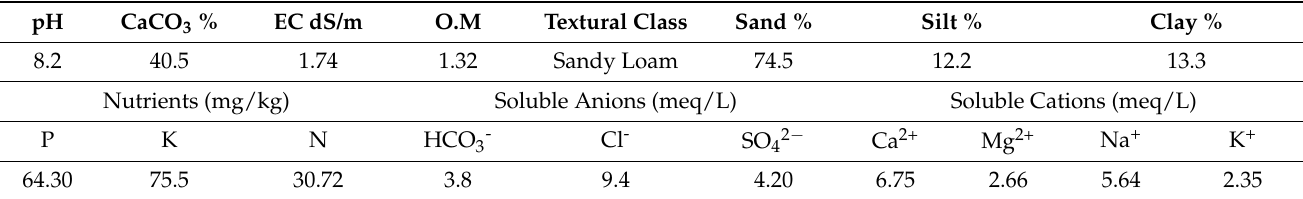
Table 1. Physicochemical analysis of the soil being